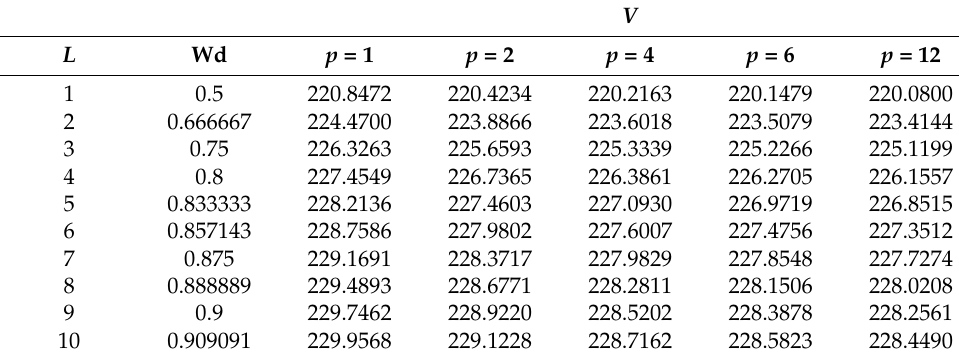
Table 2. The dependence of the company value ( V ) on the leverage level ( L ) of a three-year-old company for advance profit tax payments with frequencies of p = 1, 2, 4, 6 and